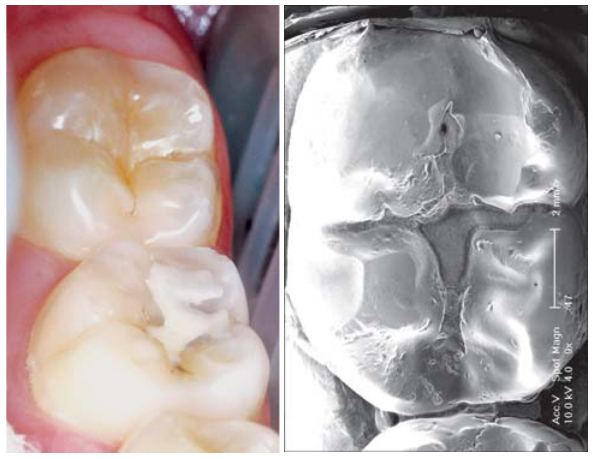
FIGURE 5- Clinical and SEM aspect of a two-year old glass- ionomer fissure sealing in a 47.